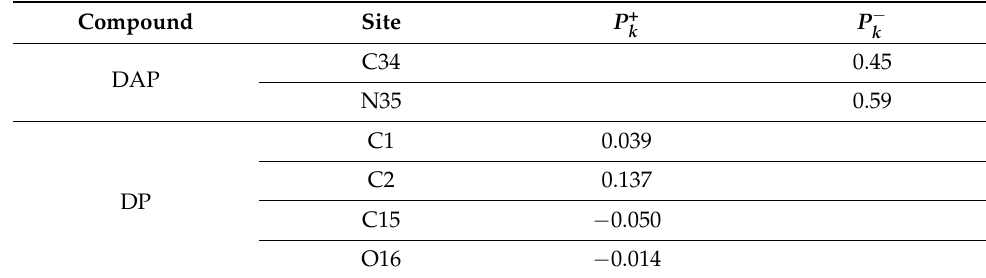
Table 1. Computed local Parr reactivity descriptor for nucleophilic attack (𝑃 (cid:3038)(cid:2878) ) and electrophilic attack (𝑃 (cid:3038)(cid:2879) ) at B3LYP/6-311G+(d.p).